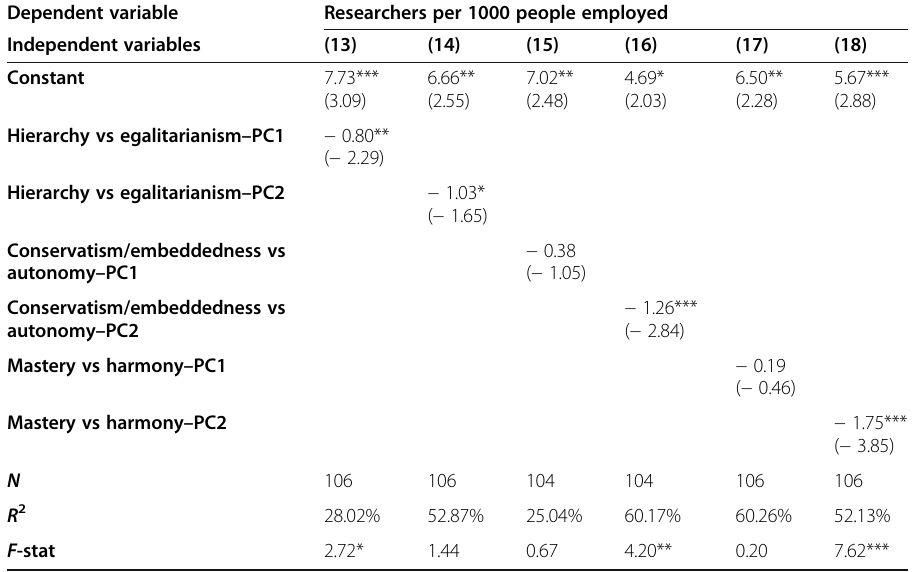
Table 12 The effect of culture on the number of researchers per 1,000 people employed Dependent variable